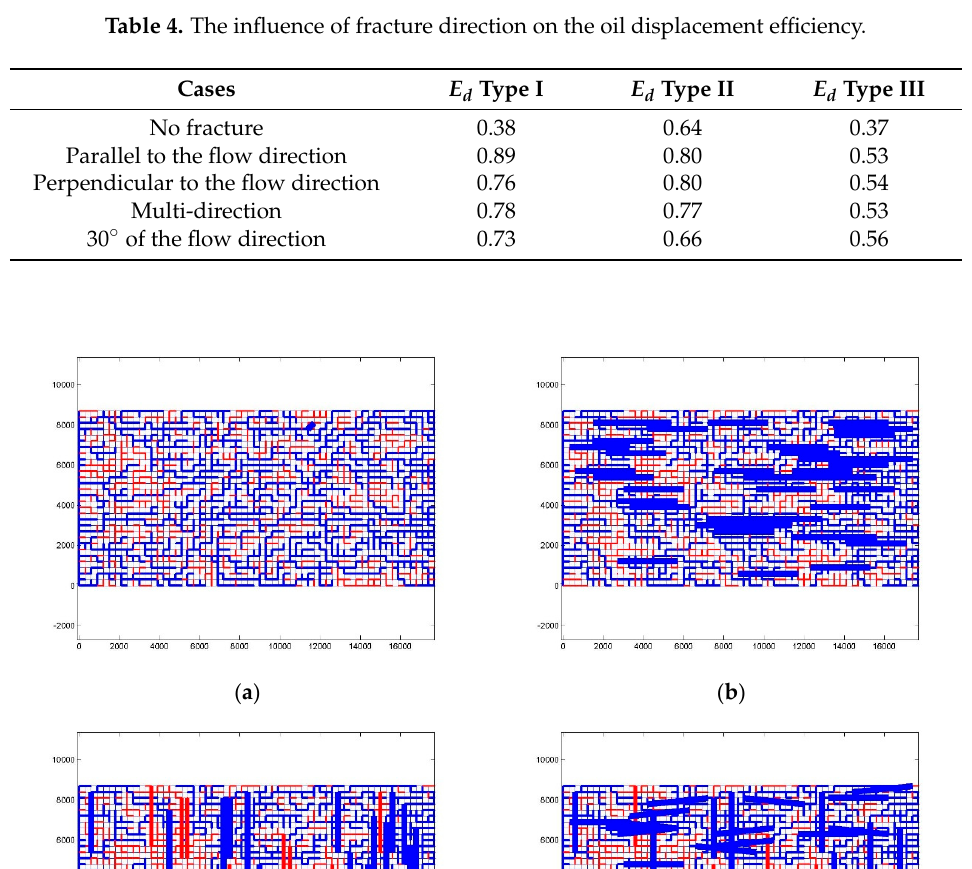
Table 3. The influence of fracture direction on the absolute permeability.